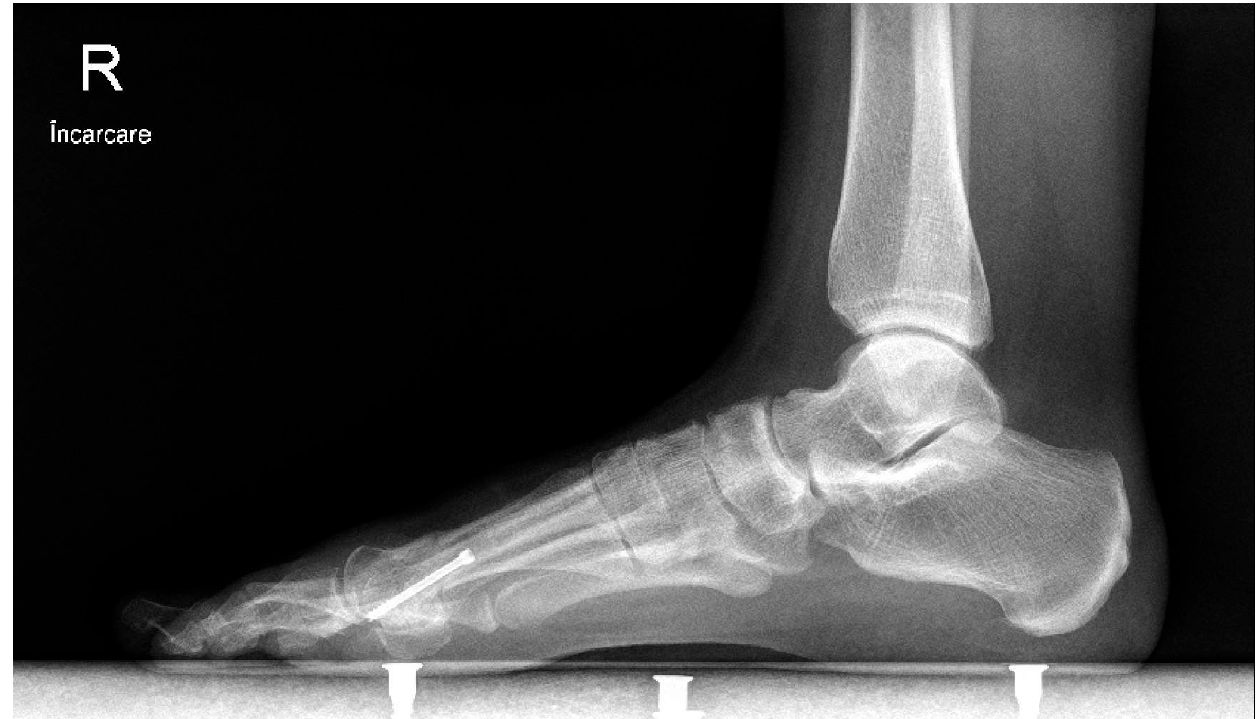
Figure 3. Lateral weight-bearing image at 12 months after surgery.